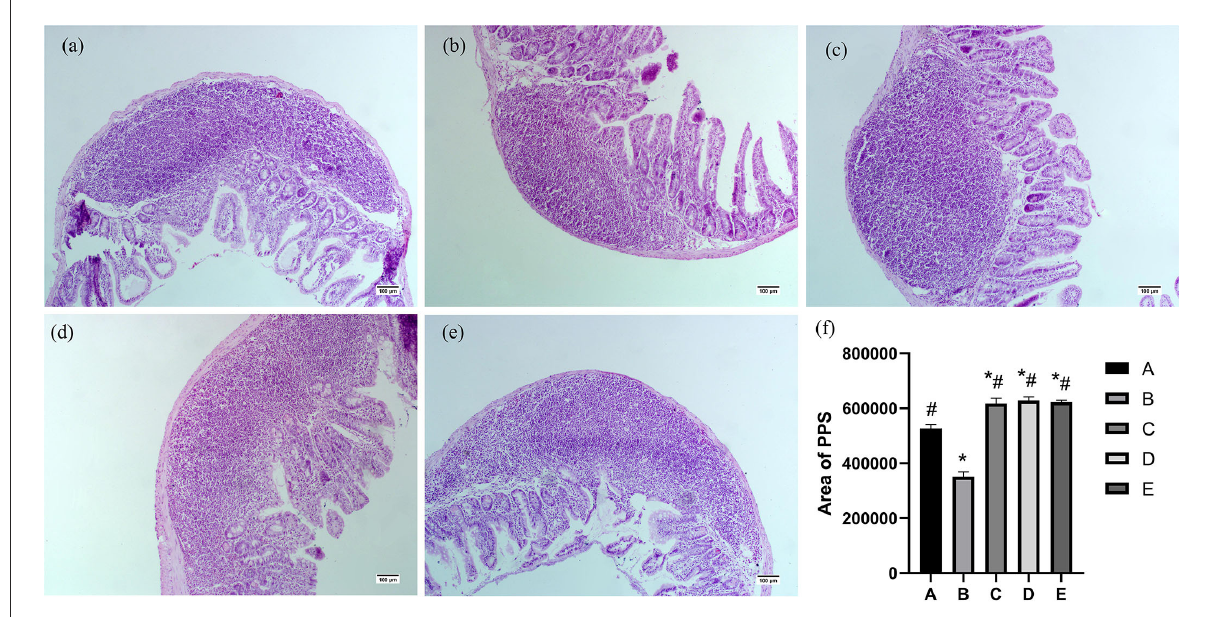
FIGURE4 Effects of CSPCM on the morphological features and area analysis of PPS. (a) Morphological observation of duodenum in group A. (b) Morphological observation of PPS in group B. (c) Morphological observation of PPS in group C. (d) Morphological observation of PPS in group D. (e) Morphological observation of PPS in group E. (f) Effects of CSPCM on area analysis of PPS. * Significant difference with group A ( P < 0.05). # Significant difference with group B ( P < 0.05).